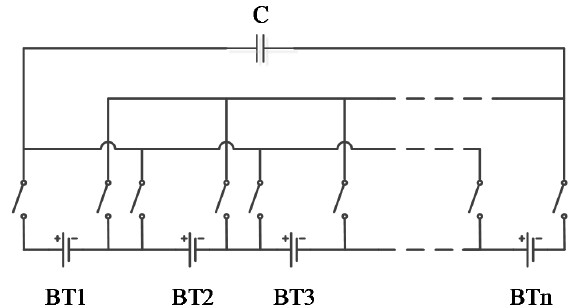
Figure 1. Principle of flying capacitor balance.